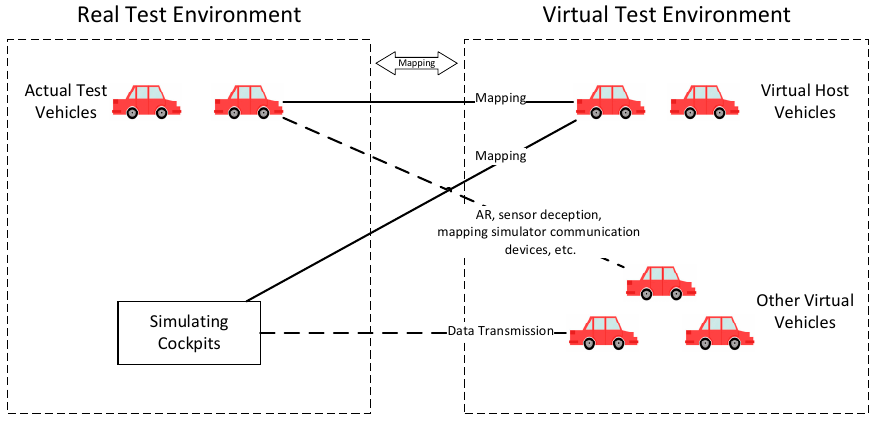
Figure 8. Parallel Testing Architecture.